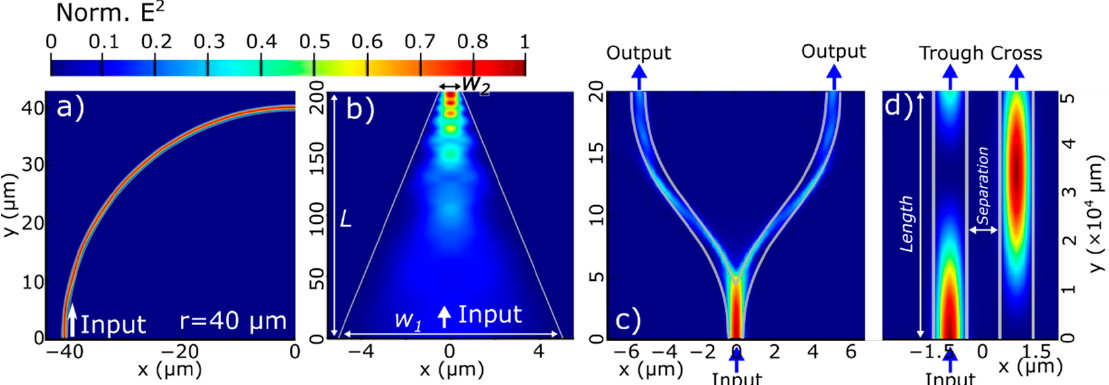
Figure 9. Simulations of electric field distribution at the middle of a 60 nm-thick Si 3 N 4 core with SiO 2 cladding for (a) a bend with radius of 40 µm; (b) a tapper to couple a WG with width w 1 = 10 µm to one with w 2 = 1 µm; (c) Y-splitter, (d) Directional coupler. All the results are from FDTD calculations for λ = 509 nm in ( a ),( b ),( c ), and for λ = 633 nm in ( d ).